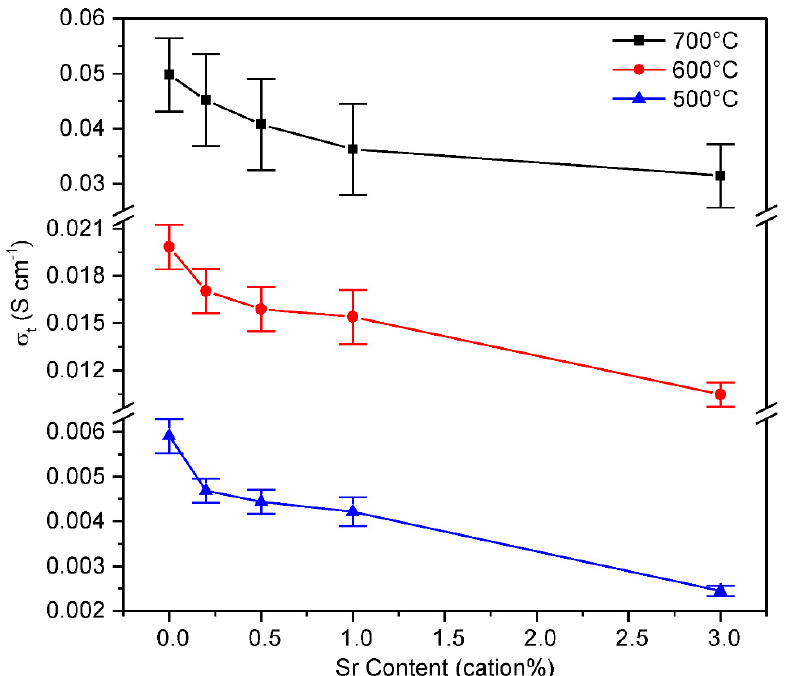
Figure 13. Plot of total conductivity measured at 500 °C, 600 °C and 700 °C as a function of Sr content for all Ce 0.8 − x Sm 0.2 Sr x O 2 − δ samples.